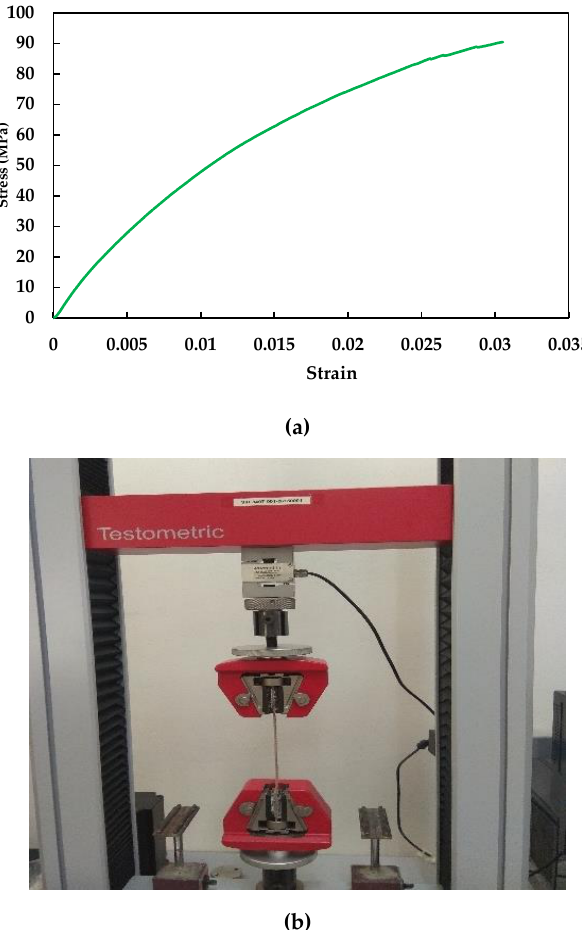
Figure 5. ( a ) The stress-strain curve of the jute–polyester fiber reinforced polymer (JPFRP) hybrid Figure 5 . ( a ) The stress-strain curve of the JPFRP hybrid composite; ( b ) M500-50-AT computer controlled UTM. composite. ( b ) The M500-50-AT computer-controlled